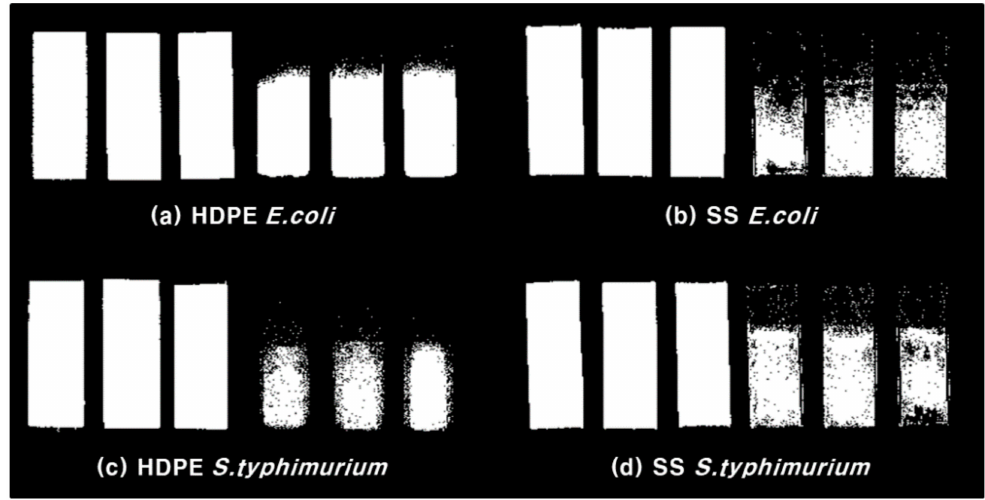
Figure 10. Region of interest of coupons (left) and bacterial biofilm detection result (right): ( a ) E. coli cultivated on HDPE, ( b ) E. coli cultivated on SS, ( c ) S. typhimurium cultivated on HDPE, and ( d ) S. typhimurium cultivated on